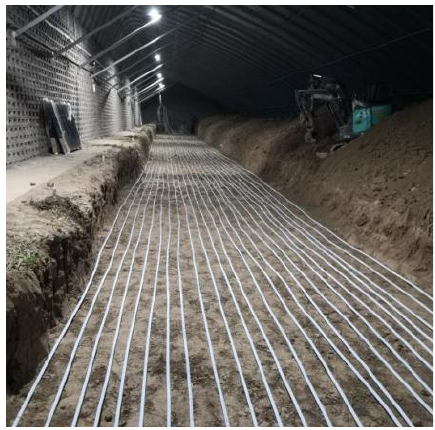
Figure 4. Horizontal heating pipe layout.